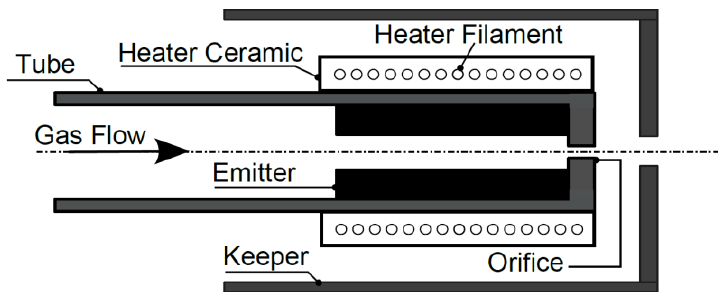
Figure 1. General schematic of an orificed hollow cathode.